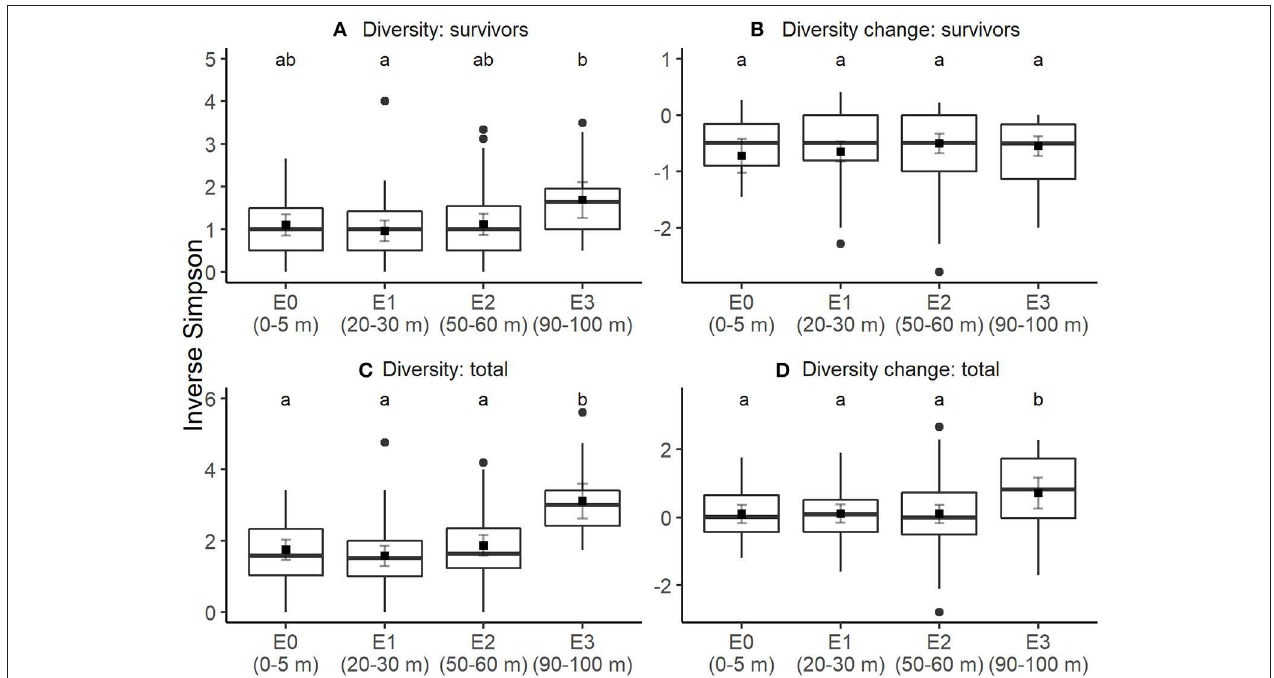
FIGURE 1 | Edge effects on seedling diversity. Through an annual recruitment cycle, at increasing distances from the forest edge, (A) diversity of established seedlings alive at the end of the experiment, (B) change in diversity between initial seedling cohort and final survivors, (C) total seedling diversity including both recruits and survivors, and (D) change in diversity between initial seedling cohort and final seedling cohort including recruits. Boxes correspond to median (central line), first and third quartile of the data and whiskers correspond to 1.5 times the inter-quartile range. Square points show the estimated mean response and gray lines are the associated 95% confidence intervals, assessed using linear mixed effects models with station as a random intercept. Letters denote significance (at alpha = 0.05) of pairwise comparisons assessed using Tukey’s post-hoc tests, with P-value correction for multiple comparisons.